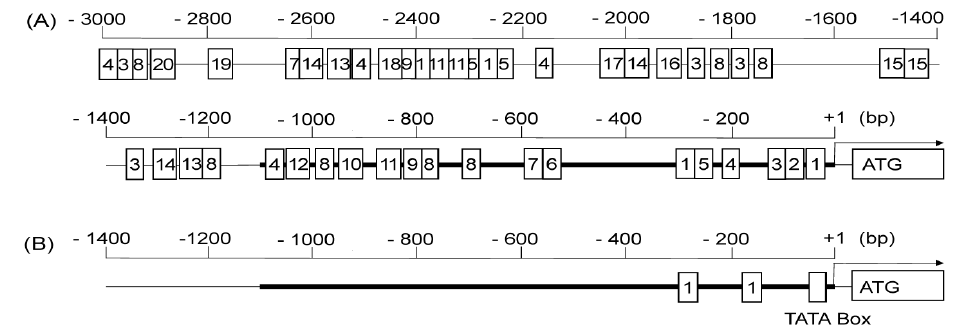
Figure 4. Schematic diagram of core promoter motifs predicted in the 5 ′ sequences of AtHKT1;1 . The region of approximately 3 kbp upstream of the AtHKT1;1 gene was searched for potential regulatory motifs. Possible cis-elements (motifs) were predicted by ( A ) the Arabidopsis Gene Regulatory Information Server [13] and ( B ) the plant-promoter database, version 3.0 [14]. The promoter region of approximately 1.1 kbp used in this study is shown in bold line. In ( B ), the region upstream of –1400 bp was omitted. Numbers in boxes indicate potential regulatory motifs; 1, ABRE-like binding-site motif; 2, SORLIP1; 3, GATA promoter motif; 4, T-box promoter motif; 5, G-box promoter motif; 6, SORLREP5; 7, ATB2 / AtbZIP53 / AtbZIP44 / GBF5 BS in ProDH; 8, RAV1-A binding-site motif; 9, BoxII promoter motif; 10, AtMYC2 BS in RD22; 11, DPBF1 and 2 binding-site motif; and 12, GCC-box promoter motif;